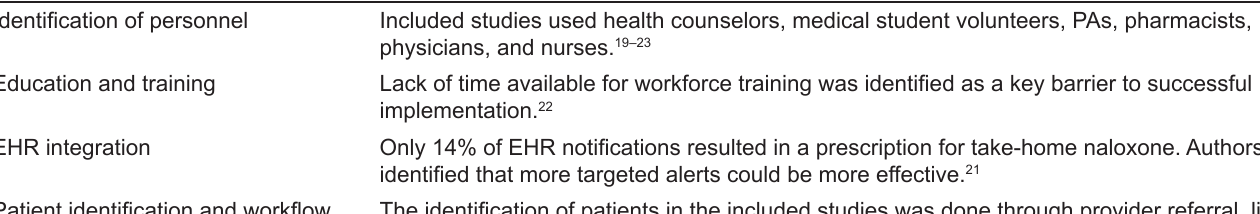
Table 2. Implementation considerations for take-home naloxone programs in the emergency